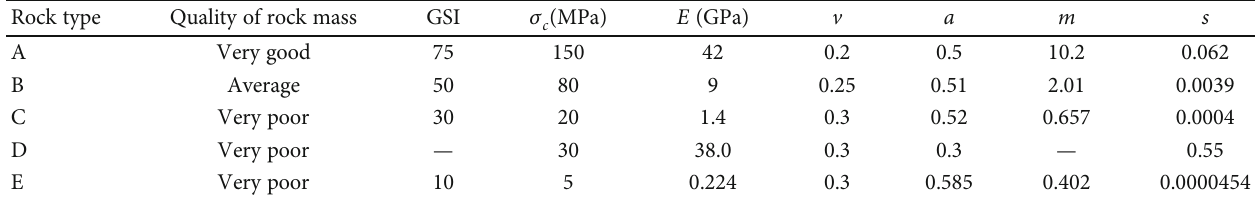
Table 1: Basic parameters of the generalized Hoek-Brown criterion used for example study.